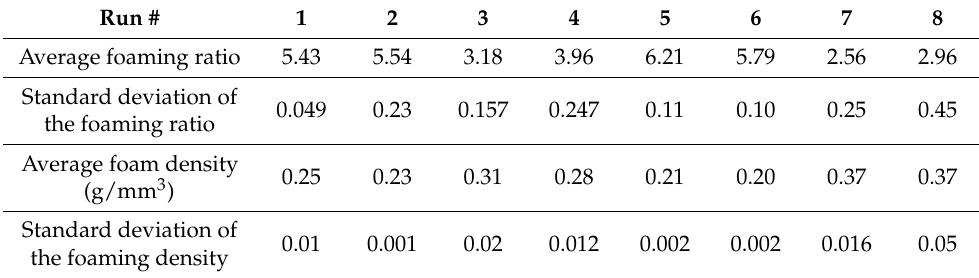
Table 3. Average calculated foaming ratio and average foam density for each set of experiments. Run #